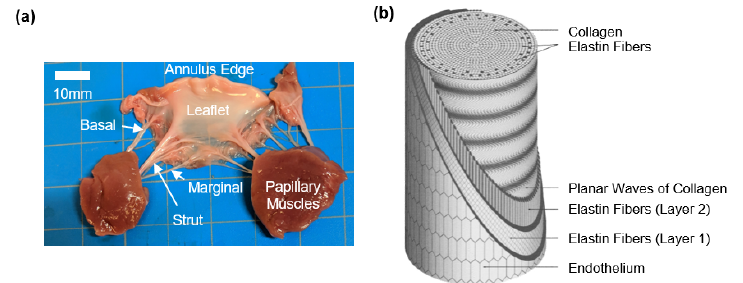
Figure 1. ( a ) An excised porcine mitral valve anterior leaflet with basal, strut, and marginal chordae tendineae. ( b ) Schematic of the microstructural components of the chordae tendineae (image from Millington-Sanders et al. [22] with permission from Wiley Global).